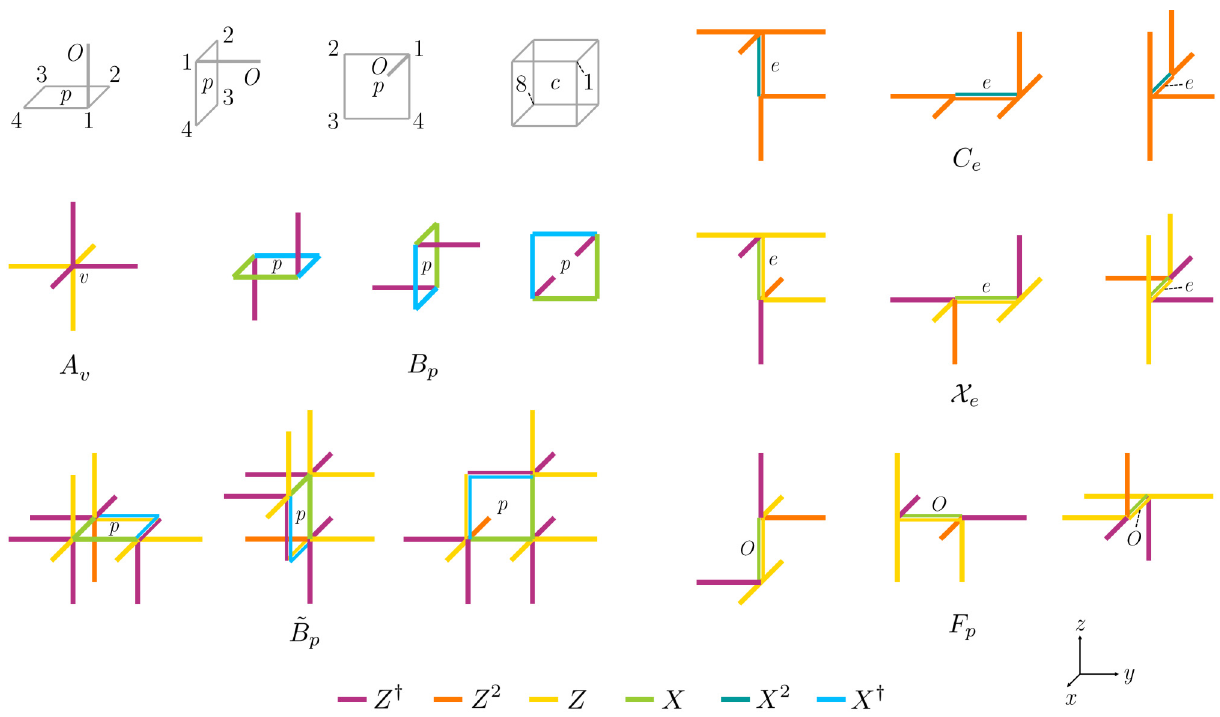
Z 4 Pauli operators over the indicated